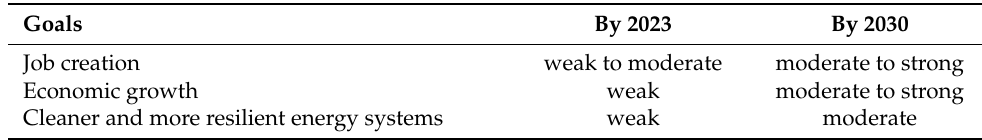
Table 10. Aggregated experts’ consensus on the impacts of increasing bioenergy demand to the post-COVID19 recovery, across different